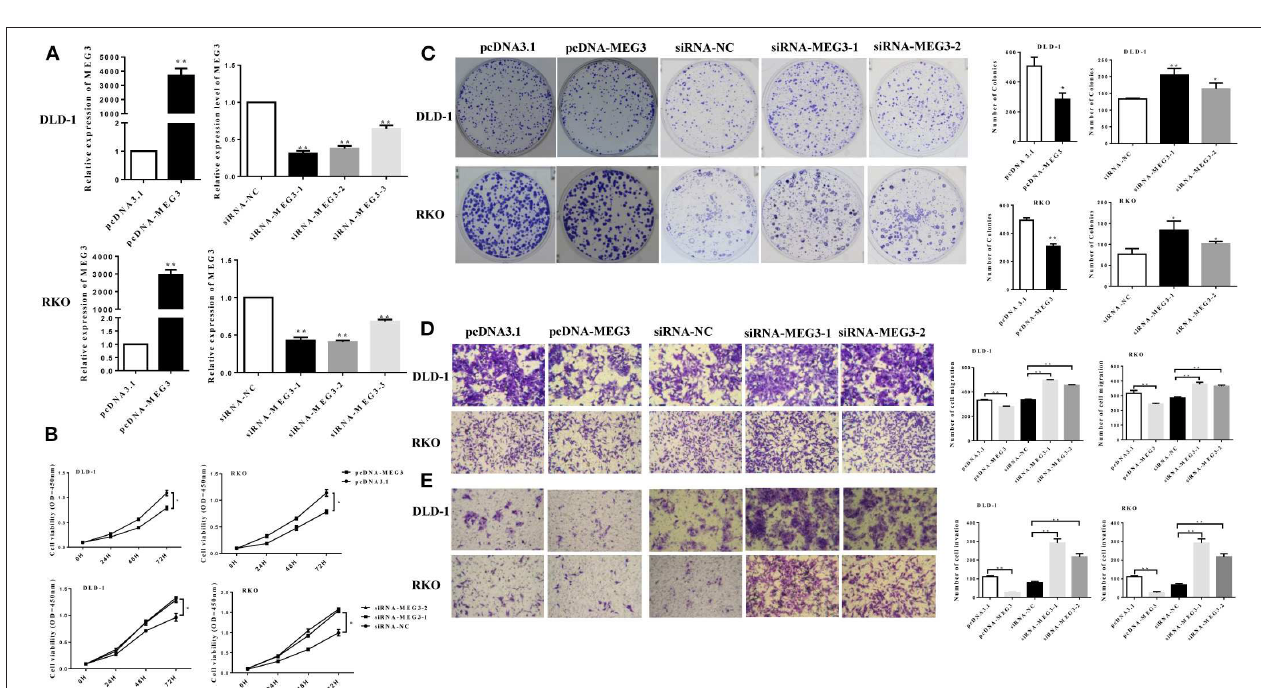
FIGURE 1 | Maternally expressed gene 3 ( MEG3 ) is downregulated in colorectal cancer (CRC) tissues, and low expression of MEG3 is associated with poor prognosis of patients with CRC. (A) Expression of MEG3 is significantly lower in CRC tissues than in corresponding non-tumor tissues ( n = 80). MEG3 expression was quantitated by qRT-PCR and plotted with log2-MEG3/glyceraldehyde 3-phosphate dehydrogenase (GAPDH). (B) MEG3 expression is negatively correlated with advanced CRC stage. (C) Kaplan–Meier survival curves showing an association between low expression of MEG3 and short overall survival in patients with CRC.